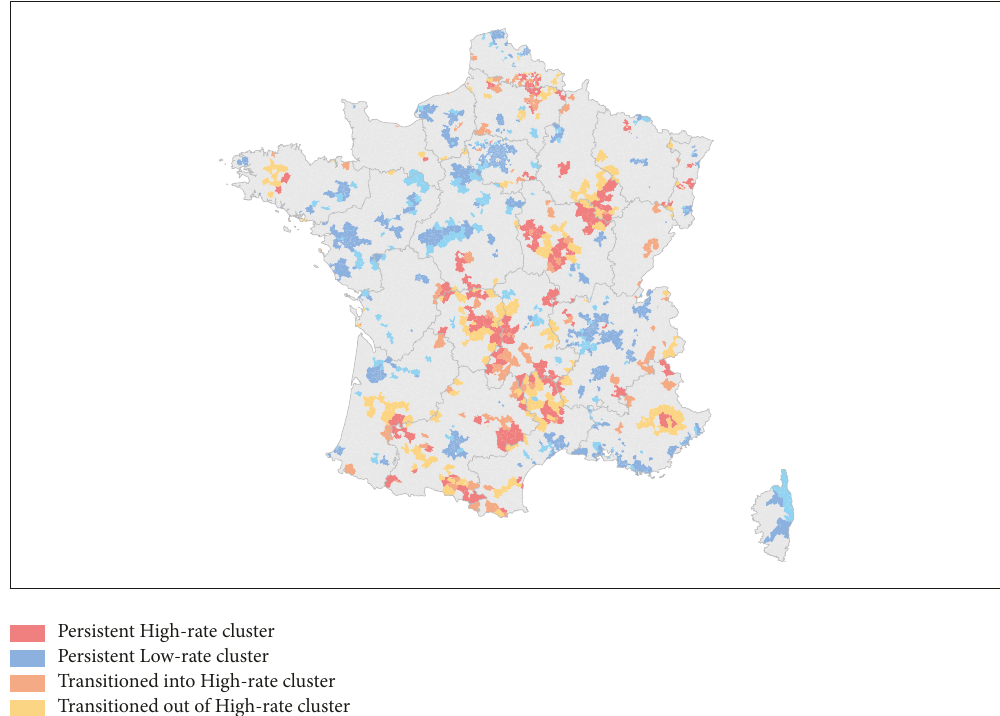
Figure 1: Clusters of age-sex-adjusted stroke hospitalization rate in France, 2009-2010 and 2012-2013.